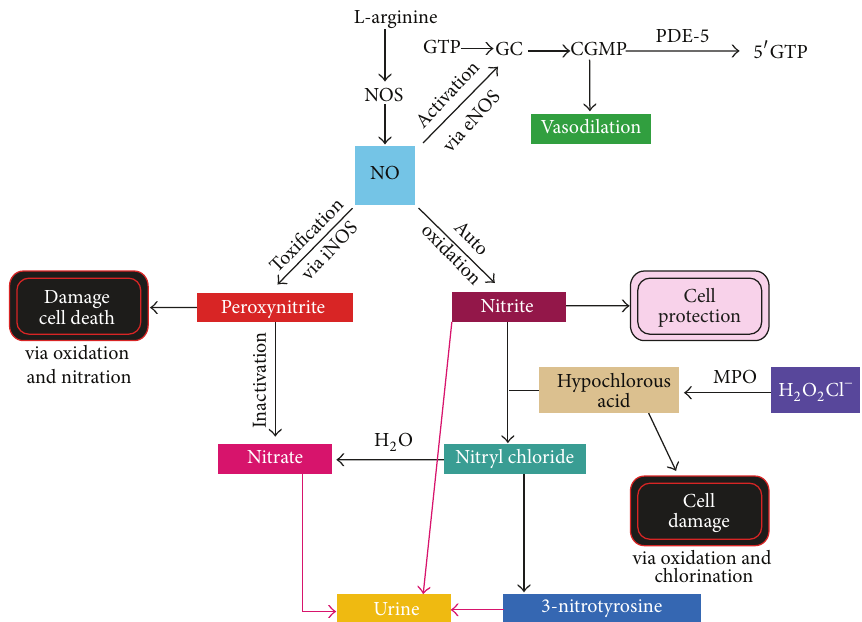
Figure 1: Nitric oxide biosynthetic pathway.